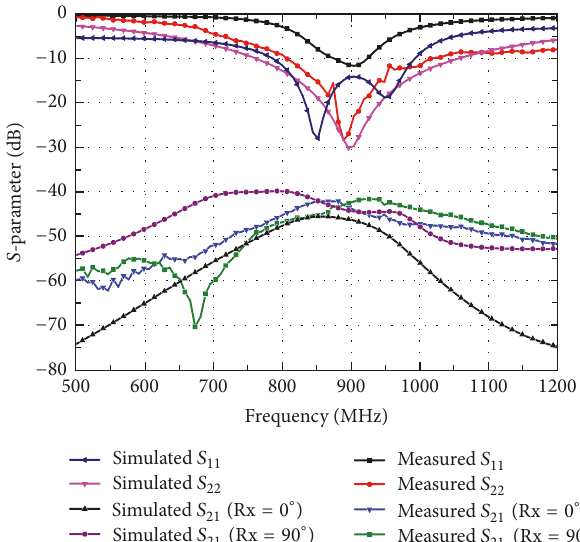
Figure 12: Measured 𝑆 -parameters of the proposed antenna and the dipole antenna.